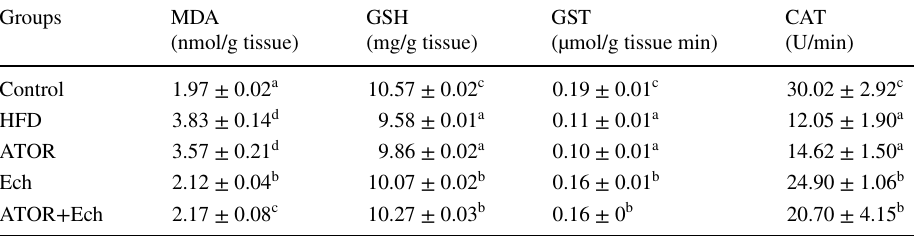
Table 6 Effect of Ech and ATOR on muscle oxidative stress biomarkers in hyperlipidemic